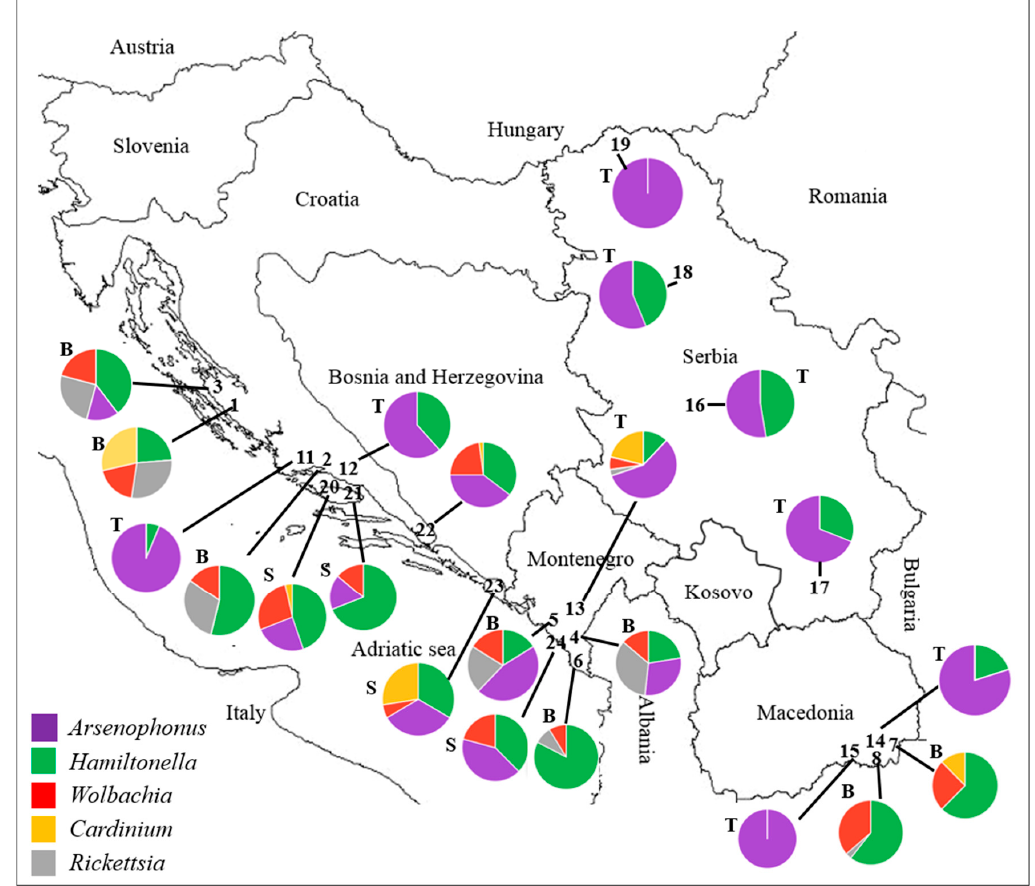
Figure 1. Locations of collected whitefly populations (according to population numbers in Table